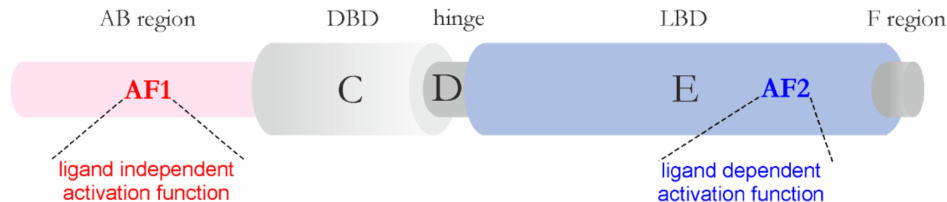
Figure 2. Structural organization of nuclear receptors. Nuclear receptors exhibit a modular structure with different regions from A to F. Some of them correspond to autonomous functional domains: the DNA-binding domain (DBD) and ligand-binding domain (LBD). Nuclear receptors have two activation functions (AFs), the ligand-independent (AF1) function, which is localized in AB region, and the ligand-dependent function (AF2), which resides in